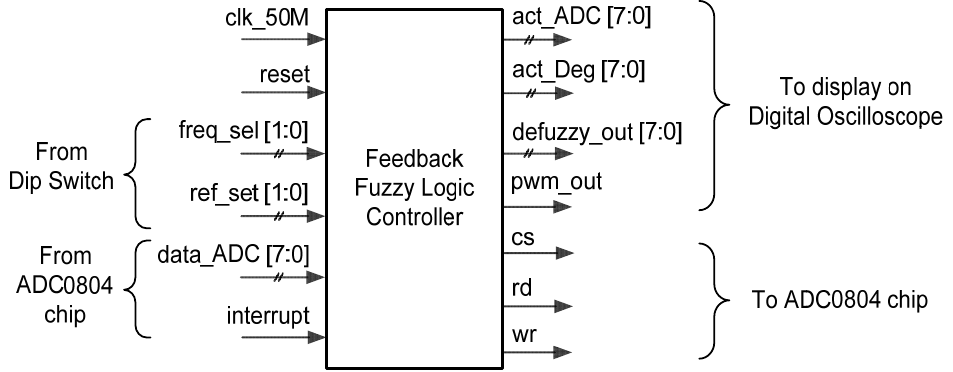
Figure 7. Top level of digital Fuzzy Feedback Controller (FFC).